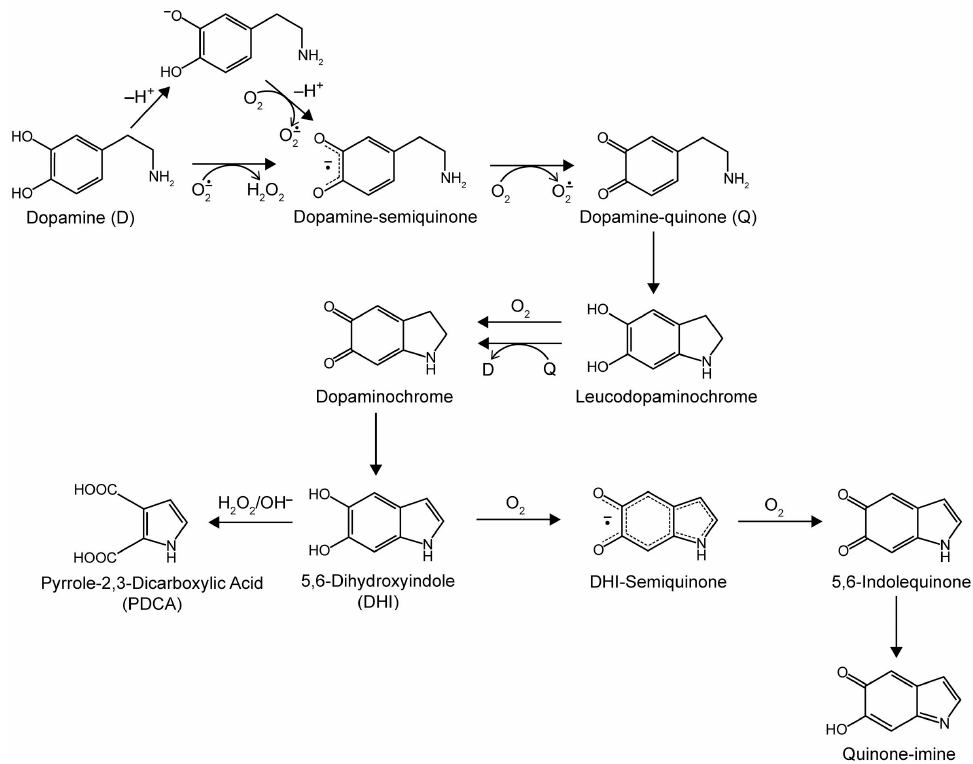
Scheme 1. Oxidation pathway of dopamine in alkaline solutions exposed to O 2 . The proposed structure of polydopamine consists of oligomers of all species shown [22,28,29].